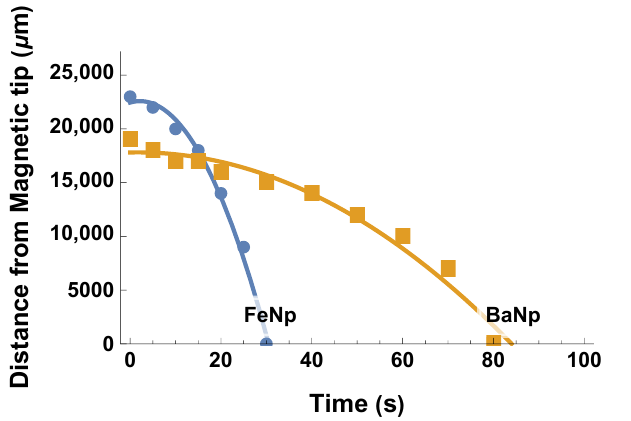
Figure 3. Magnetic nanoparticle position as a function of time, a graphical approach to v ter in the presence of gravity and a magnetic pulling force. Data points from experiments were plotted with a quadratic curve fit. The tangent slope of this curve at a specific point z above the magnetic tip is taken as the v ter observed at that position under an magnetic field